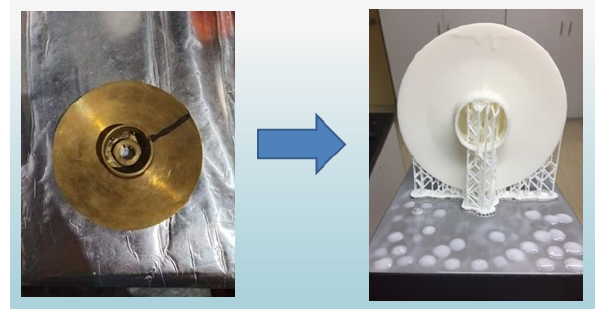
Figure 4: Metal and Plastic